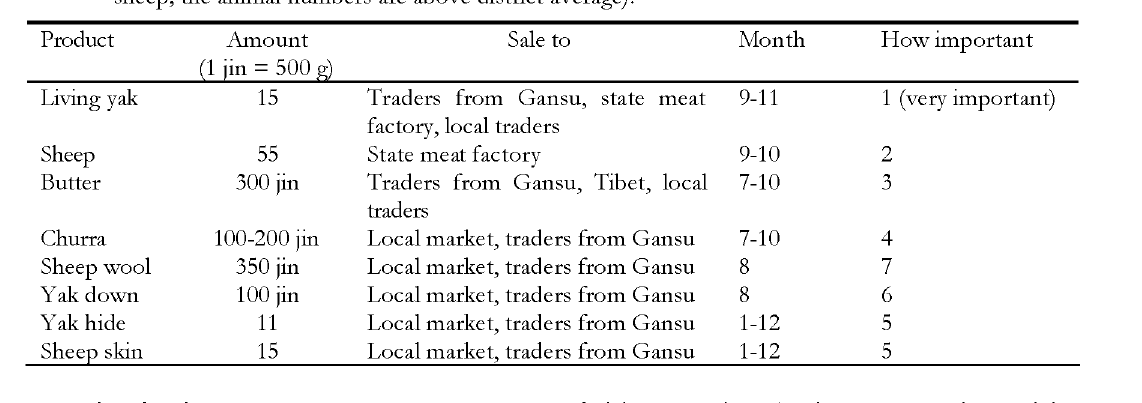
Table 1. Sales of a pastoral family in Xiamen Xiang in the year 2000. (7 family members, 105 yak, 210 sheep; the animal numbers are above district